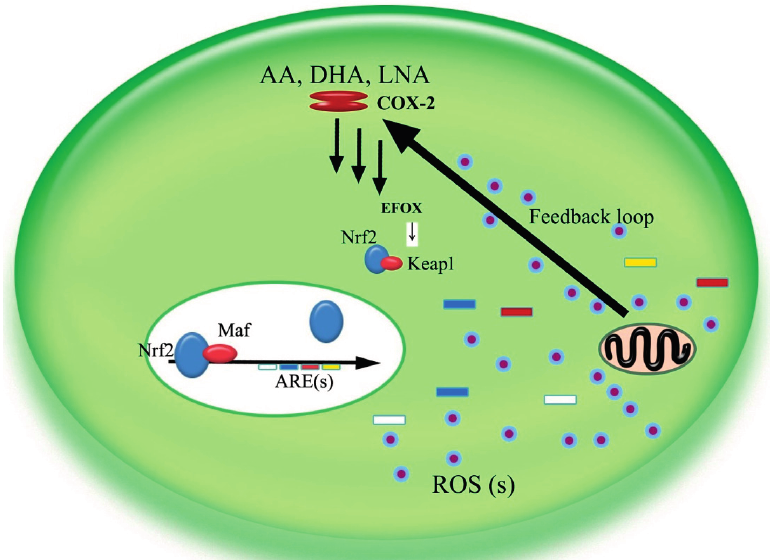
Figure 2. Diagram portraying a potential mechanism of COX-2’s antioxidative effect via EFOX (electrophilic oxo-derivative) molecules, where ROS(s) are hypothesized to trigger the antioxidative and anti-inflammatory effects largely based on the observation that COX-2 expression is increased in aging tissues. Abbreviations: AA , arachidonic acid; DHA , docosahexaenoic acid; EPA , eicosapentaenoic acid; LNA , linolenic acid; ROS , reactive oxygen species